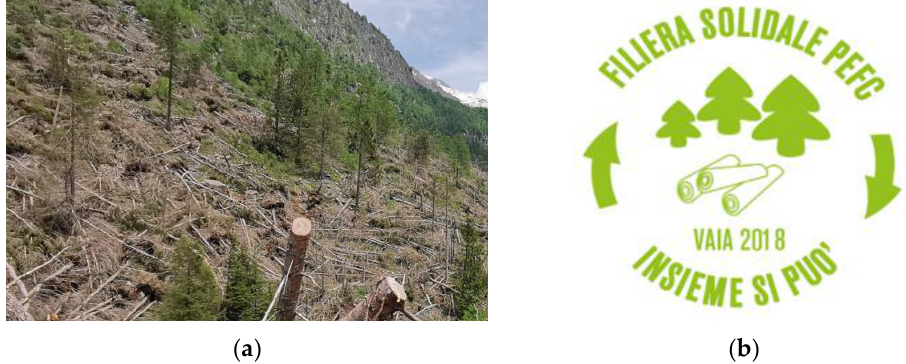
Figure 1. The Vaia windstorm strongly impacted forests in northeastern Italy. ( a ) Trees of an entire mountainside grounded by the windstorm; ( b ) Label of the PEFC fair supply chain, made of various elements: images of trees and logs represent this specific forest-wood supply chain; the top and bottom text (“PEFC fair supply chain” and “Together we can”) is ethically-focused; the central text (“Vaia 2018”) identifies the windstorm; the arrows suggest the role of the “fair supply chain” , with adhering organizations and purchasers together engaged in supporting the impacted areas.